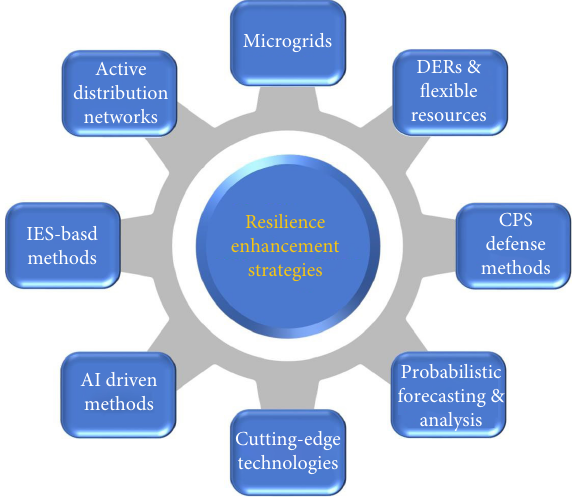
Fig. 5 Specific resilience enhancement strategies for urban power